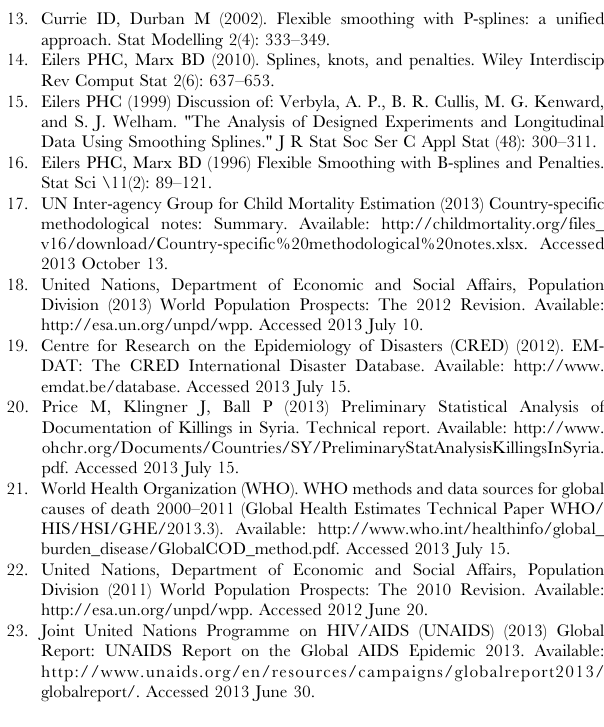
Figure S1 Comparison of UN IGME 2013 U5MR esti- mates to UN IGME 2012 U5MR estimates for all countries. UN IGME 2013 estimates are given by the solid red line (with 90% uncertainty intervals denoted by the shaded regions) while UN IGME 2012 estimates are given by the solid dark blue line and the default Loess fit to the 2013 UN IGME database is given by the dashed dark blue line. Connected dots denote data from the UN IGME 2013 database and gray shaded areas around series of observations represent the sampling variability in the series (quantified by two times of the sampling standard errors). Figure S2 U5MR estimates for 33 countries where the difference in estimation method between UN IGME 2012 and UN IGME 2013 led to an absolute difference in U5MR estimate for the year 1990 or 2011 of more